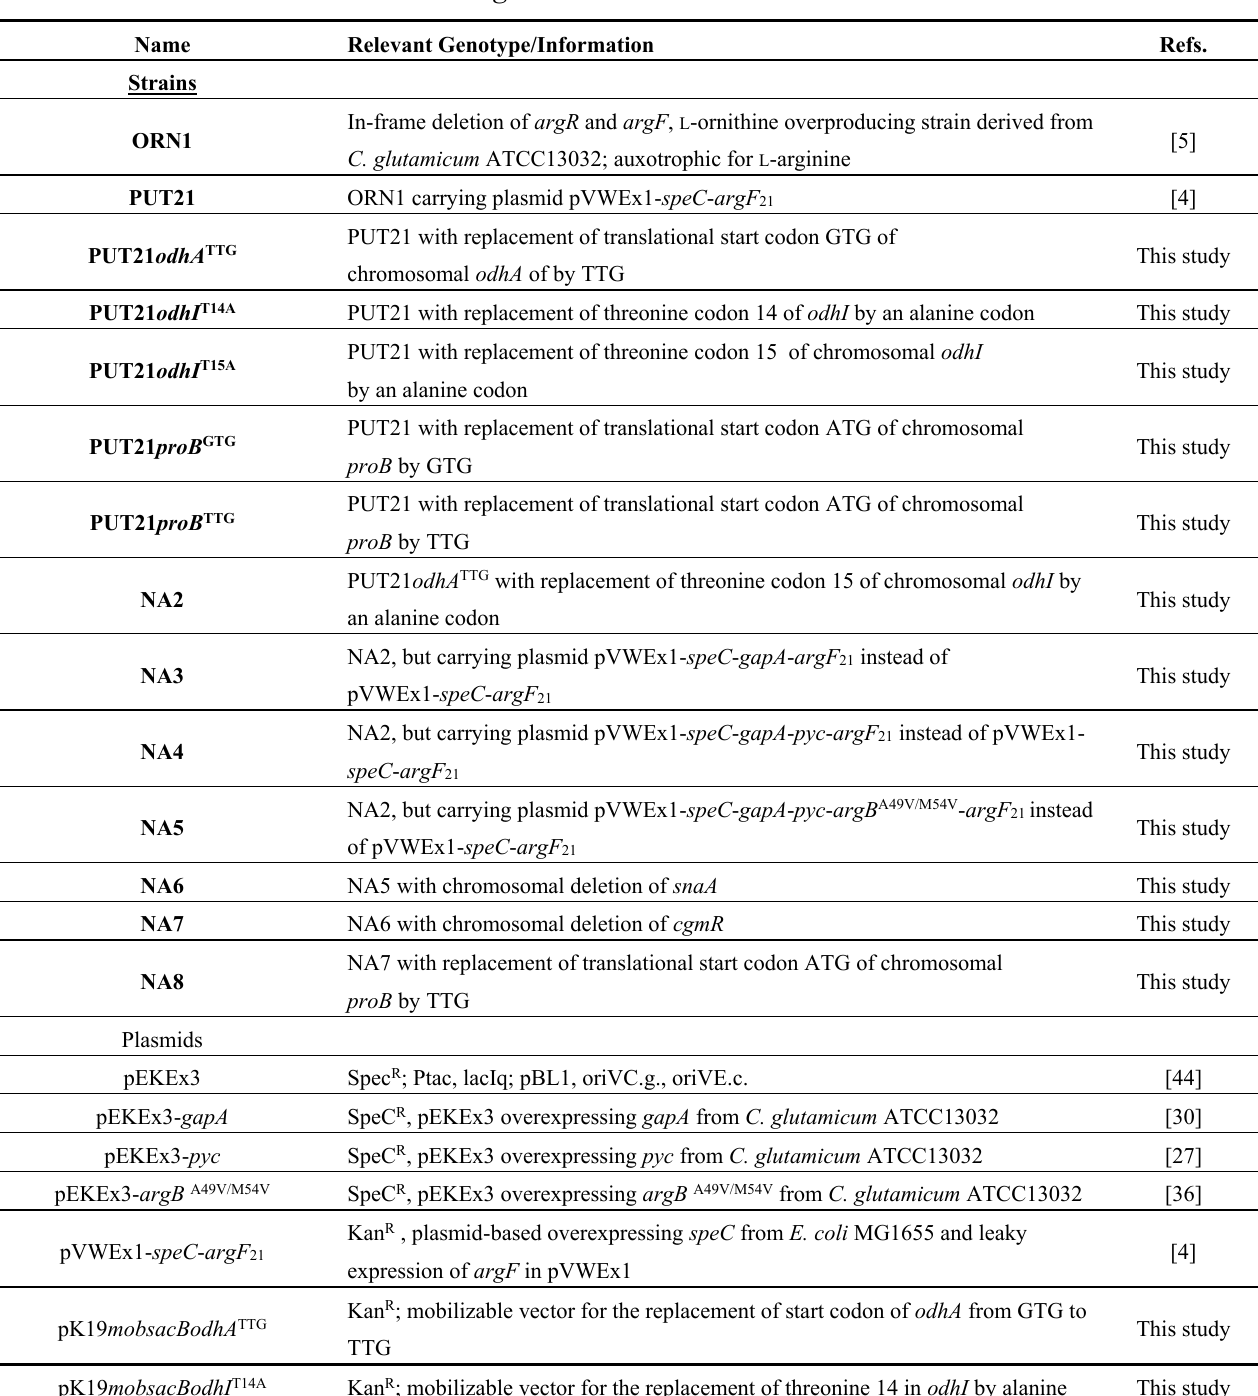
Table 3. C. glutamicum Strains and